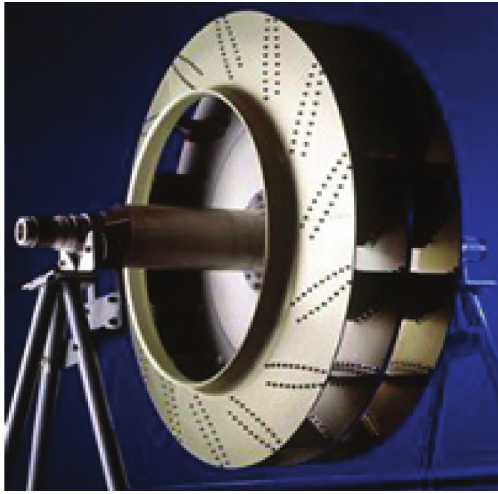
Figure 1: The baseline impeller B#1.